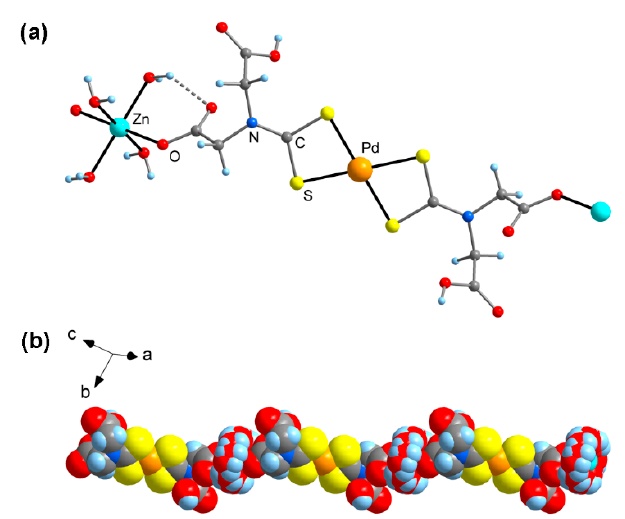
Figure 1. Molecular structure of Zn[Pd(HL) 2 ] ( 3-Pd ) · 6H 2 O in the crystal (non-coordinated crystal water omitted for clarity). ( a ) Ball-and-stick model of one formula unit; ( b ) Representation of the one-dimensional polymeric structure (space-filling model, showing rotational disorder of the Zn(H 2 O) 4 units).